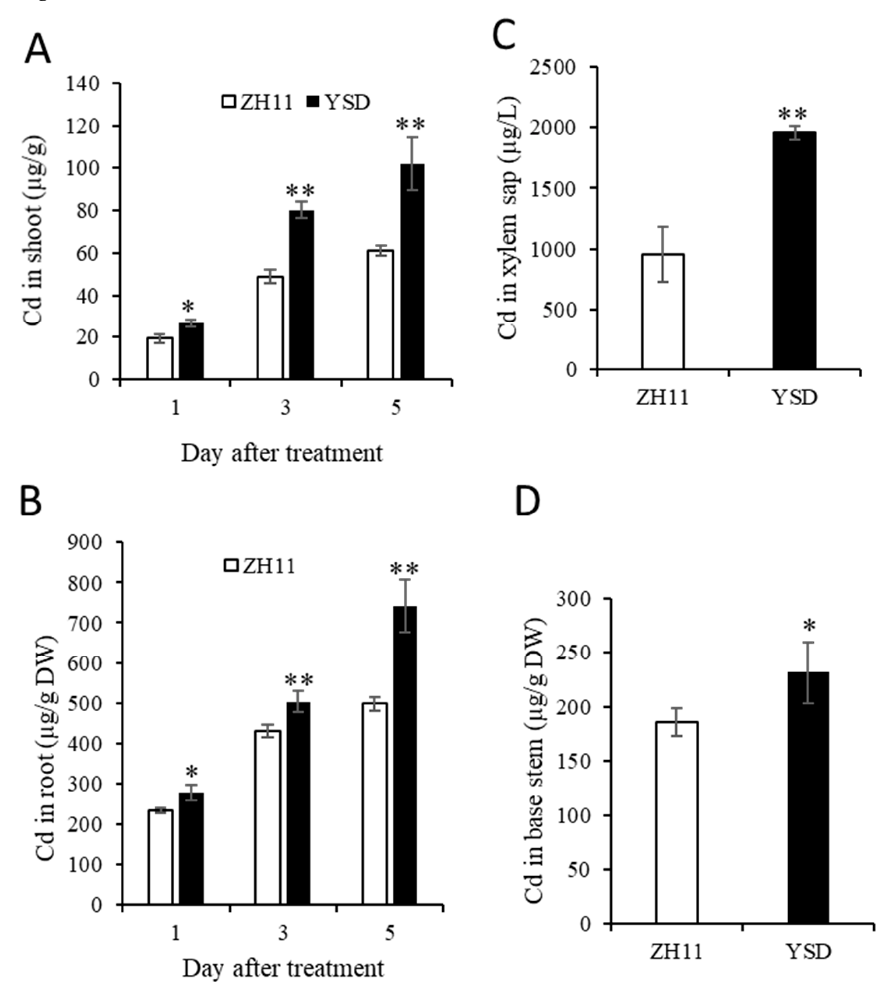
Figure 2. Time-dependent higher Cd accumulation in shoots and roots of YSD than ZH11. After 4 weeks of hydroponics, rice seedlings were treated with 10 µ M Cd for 1, 3, and 5 days, Cd content in the shoot ( A ), root ( B ), basal stem ( C ) and xylem sap ( D ) were determined by ICP-MS. Data are presented as the means ( ± SD), n = 5. Significant differences were determined using the Student’s t -test: * p < 0.05, ** p <